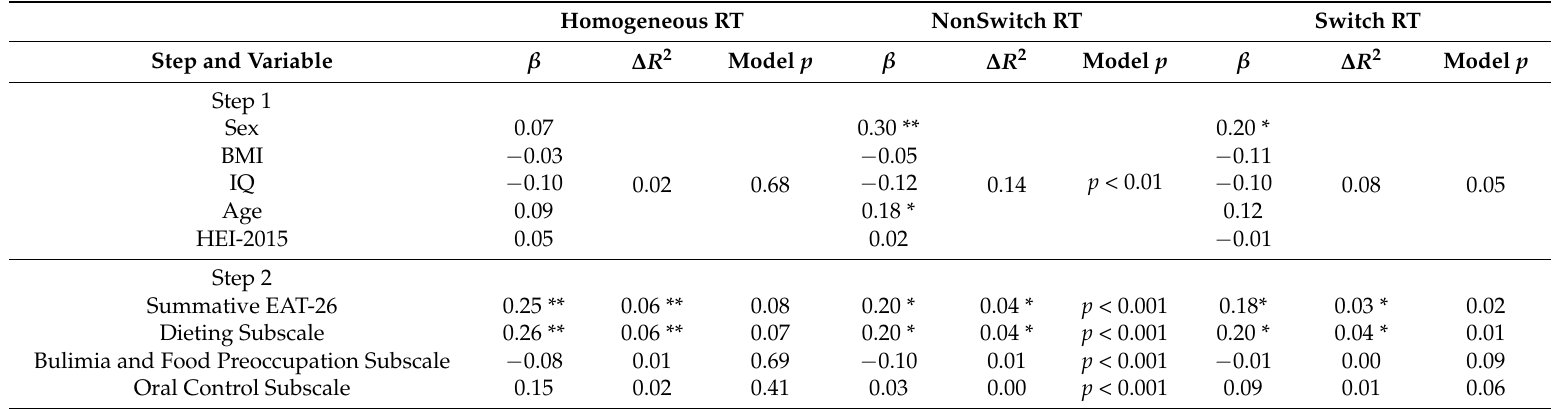
Table 4. Hierarchical Regression between pertinent variables and Switch task cognitive